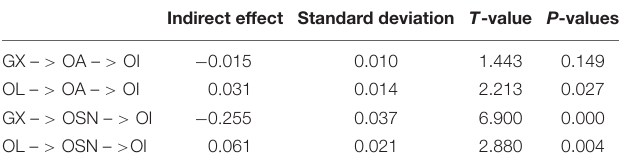
TABLE 6 | Results of the indirect effect. Indirect effect Standard deviation T -value P -values